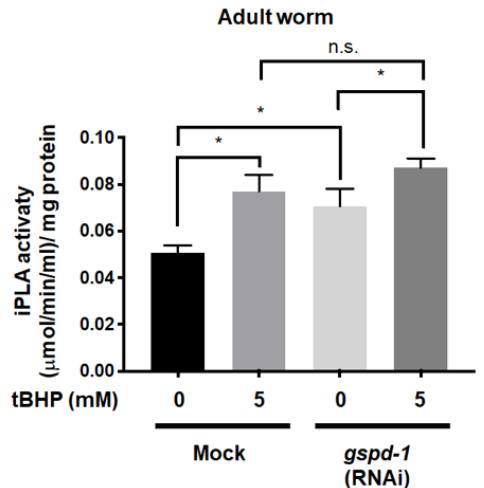
Figure 5. Increased iPLA activity in mock and gspd-1 -knockdown C. elegans after short-term